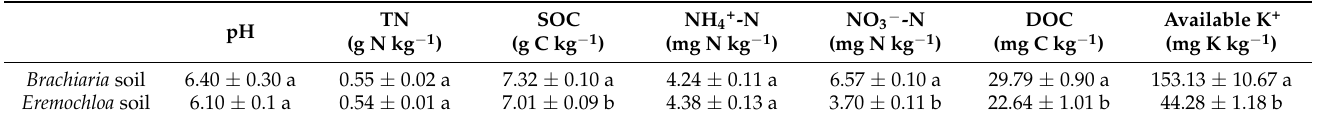
Table 1. Properties of the test soils after approximately 2 years of cultivation with Brachiaria and Eremochloa